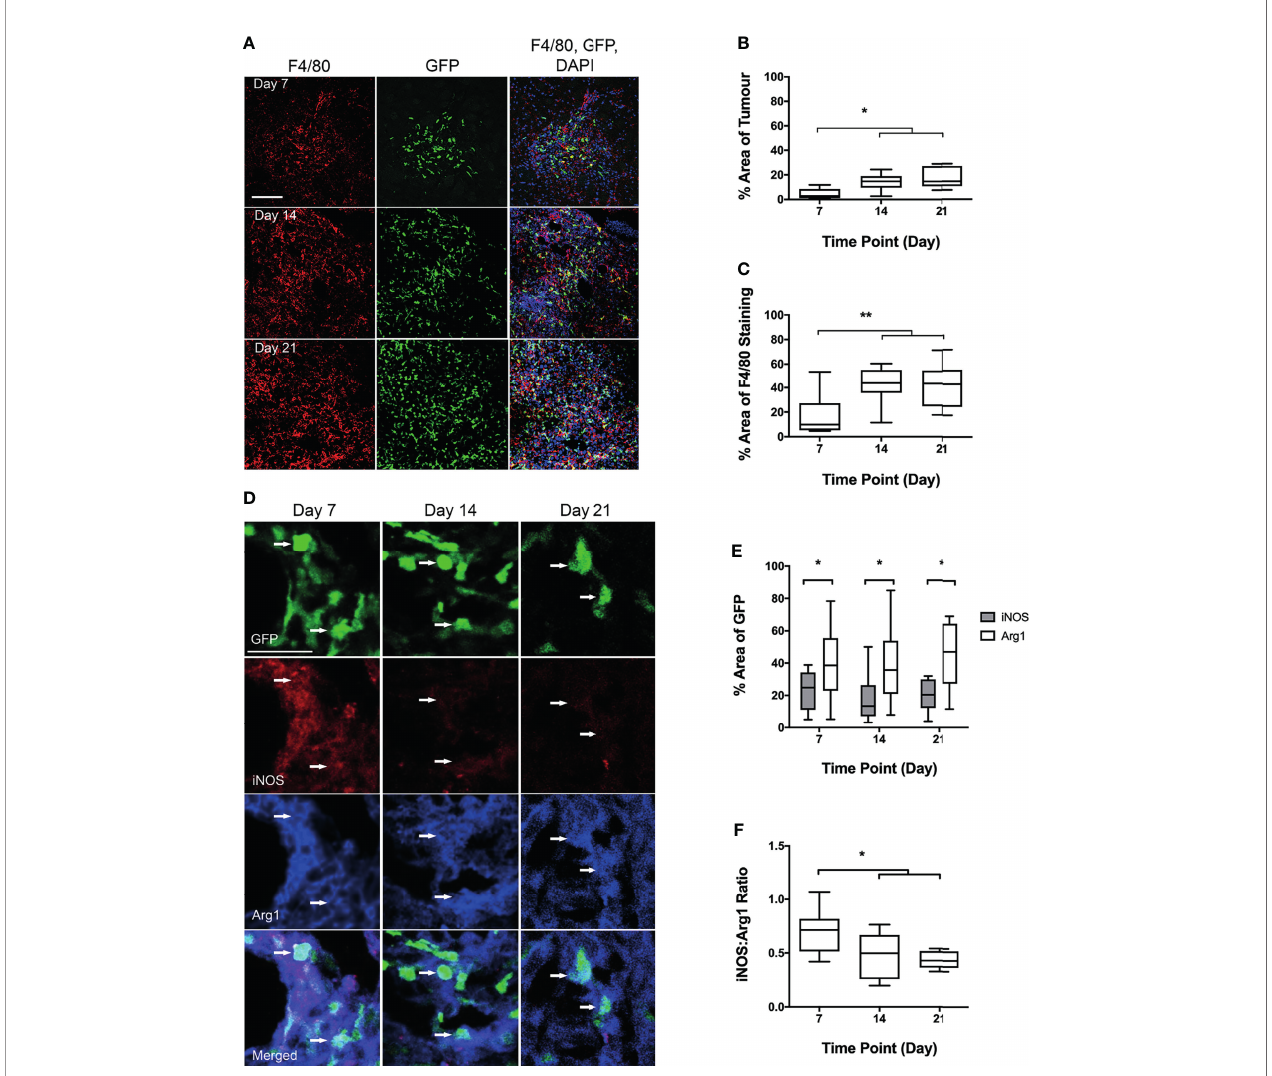
FIGURE 2 | Analysis of blood-derived macrophage (BDM) in fi ltration and phenotype into tumour foci from Lys-GFP-ki mice injected intracerebrally with EO771 cells. (A) Co-localisation of GFP fl uorescence (BDM; green) with immuno fl uorescent staining for F4/80 (all microglia/macrophages; red). Nuclei stained with DAPI (blue). Scale bar = 100 µm. (B) Graph showing percentage of tumour area that is GFP positive indicating in fi ltration of BDM. (C) Graph showing percentage of F4/80 staining that is GFP positive, indicating relative proportions of BDM and brain-resident microglia within the tumour foci. (D) Co-localisation of immuno fl uorescent staining for iNOS (pro- in fl ammatory; red) or Arg1 (anti-in fl ammatory; blue) with GFP in BDM. Arrows indicate GFP+ BDM with colocalization of iNOS and Arg1. Scale bar = 30 µm. (E) Graph showing percentage of GFP-positive area that is either iNOS (grey bars) or Arg1 (white bars) positive. (F) Graph showing ratio of iNOS : Arg1 in GFP-positive cells. N = 9 at day 7, n = 9 at day 14 and n = 10 at day 21. Data shown as box and whisker plots depicting full range of data points. *p < 0.05, **p <